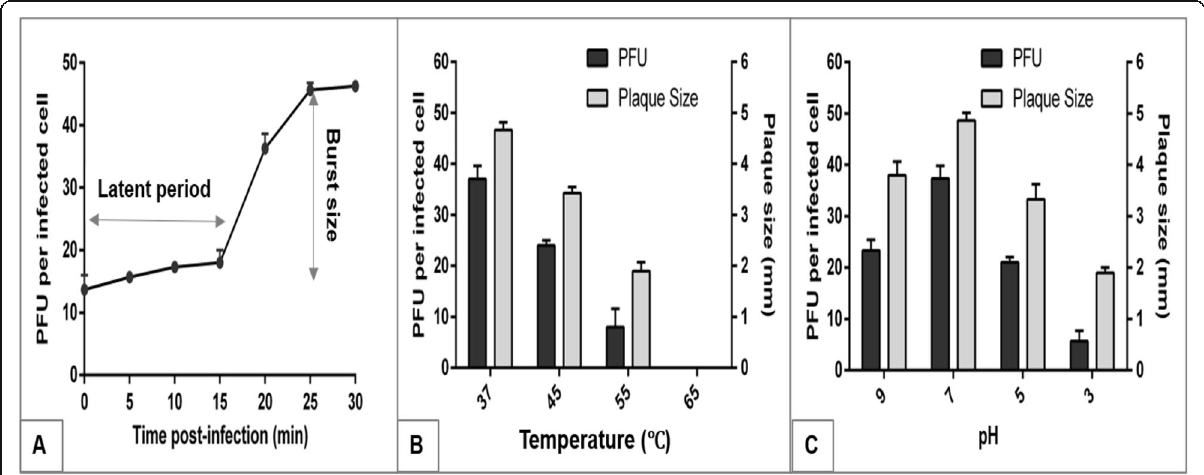
Fig. 2 One-step growth curve and stability characterization of phage ɸ sp1 growing on Ralstonia solanacearum strain 1629 at varying growth temperatures and pH. a Phage ɸ sp1 PFUs per infected cell at 5-min interval post-infection up to 30 min with dilution factor 10 2 . Phage titer was determined by performing DLA. Latent period 15 min and burst size of virus 250 – 300. b The relative number and size of visible plaques under